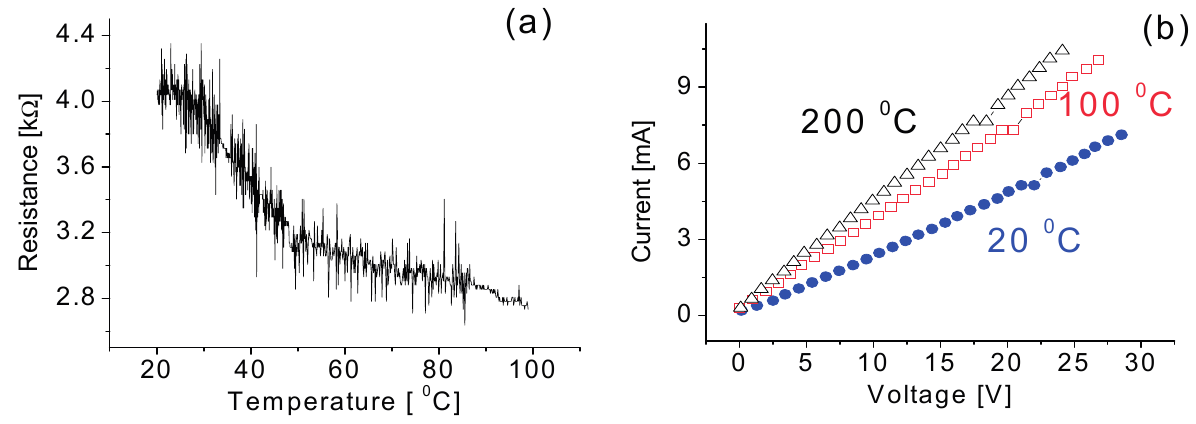
Figure 7b: (1) at a fixed temperature, the electrical current and voltage always have a linear relationship, indicating the ohm contact between the electrodes and the nanowires, and that there is no more charge accumulation or polarization effect in the circuit; and (2) the electric properties of the nanoparticle-based nanowires are sensitive to temperature. The reason of this is that zero-dimension structures like nanoparticles have much strong mutual link condition. Thus, the intrinsic structure of nanoparticles will undergo a great change with temperature.